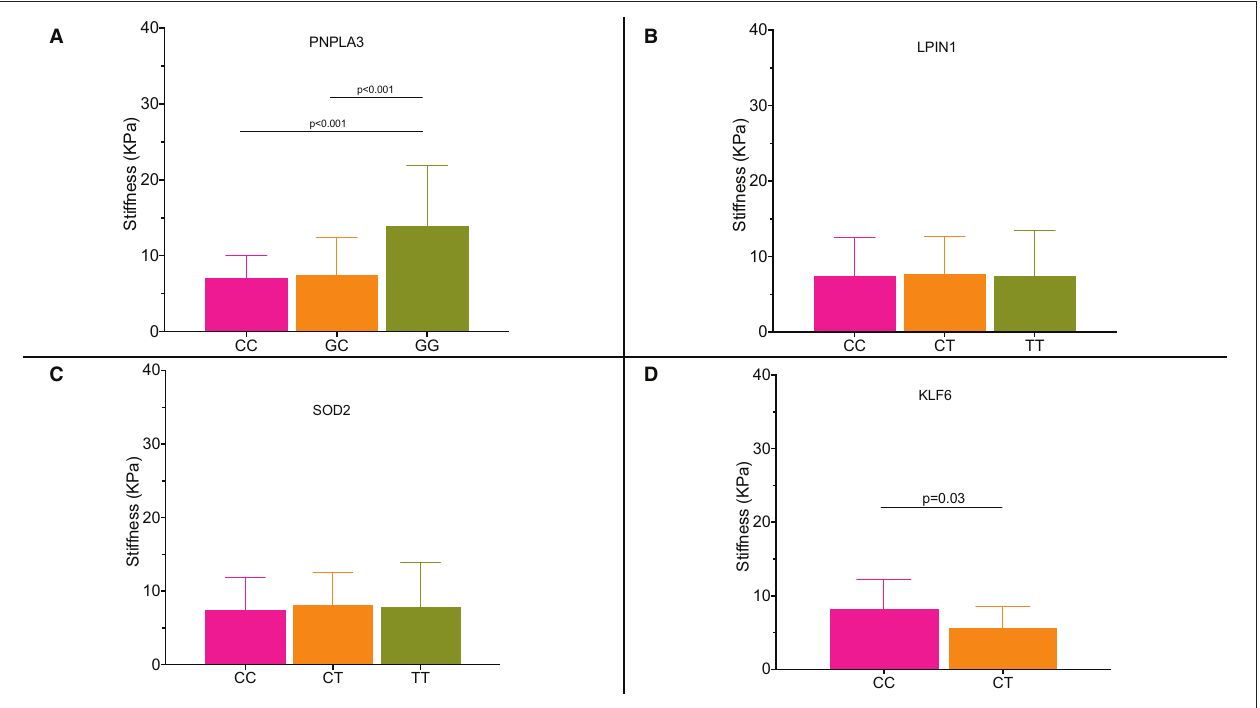
FIGURE 4 | (A–D) Liver stiffness expressed as KPa according to the single nucleotide polymorphisms and their genotypes.